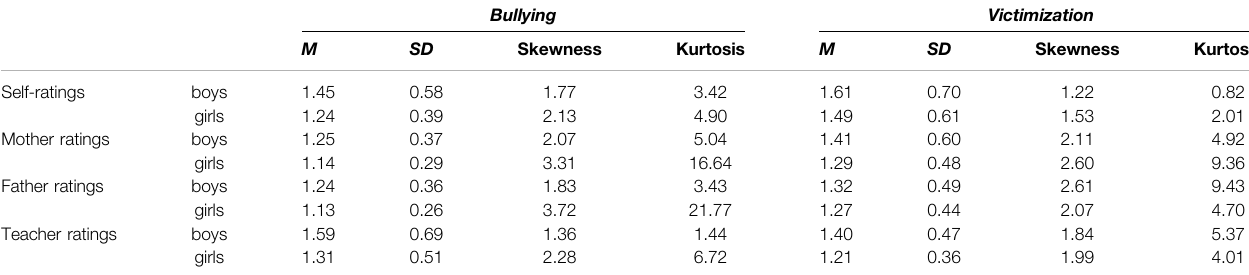
TABLE 4 | Distribution parameters for bullying and victimization